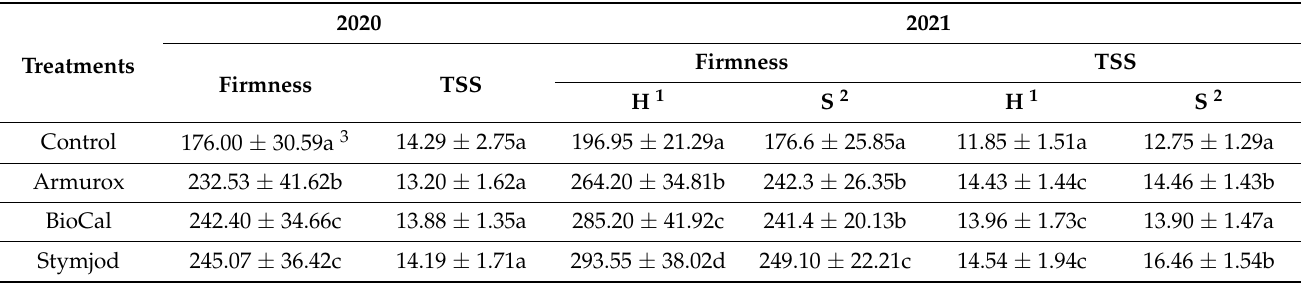
Table 6. Effect of foliar fertilization on blueberry fruit firmness (g mm − 1 ) and TSS content (%) in 2020 and 2021 (TSS—total soluble